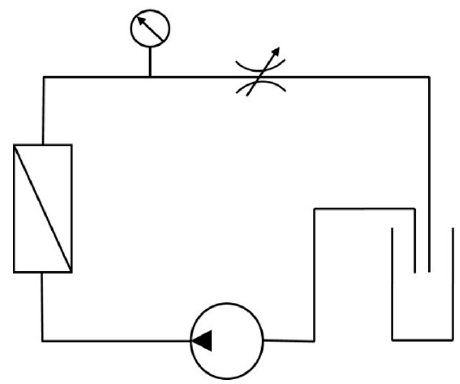
Figure 3. Scheme of the filtration system.